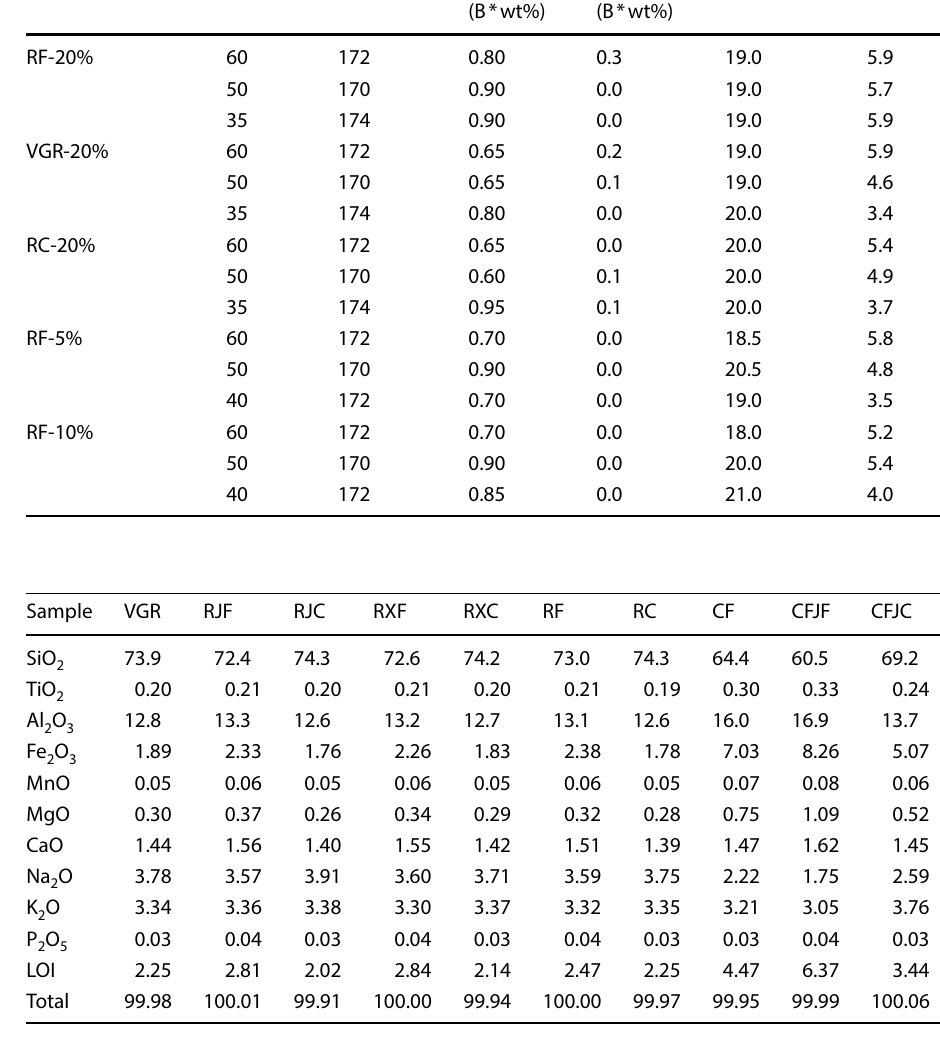
Table 4 Test levels, proportioning factors and fresh test results